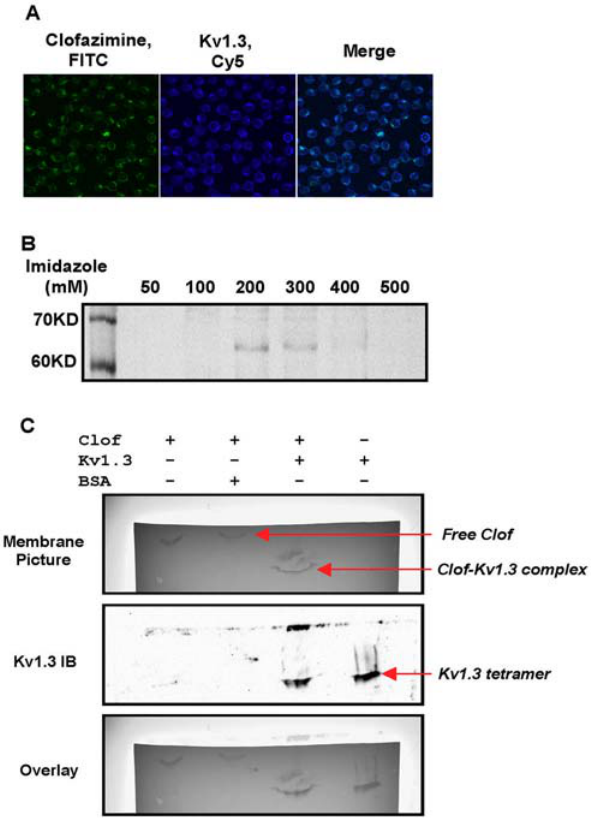
Figure 4. Interaction between clofazimine and Kv1.3 invivo and invtro. ( A ) Clofazimine colocalizes with Kv1.3 on the plasma membrane of Jurkat T cells. Clofazimine was visualized in FITC channel while Kv1.3 was stained by Cy5 secondary antibody. ( B ) SDS-PAGE analysis of His- Kv1.3 purified from 293 T cells upon staining with Coomassie blue. Recombinant Kv1.3 protein was found in the 200 and 300 mM imidazole elution fractions. ( C ) Gel shift of clofazimine by Kv1.3 on native polyacrylamide gel. 10 m M Clofazimine was incubated with buffer alone (lane 1), 2 m M BSA (lane 2) and 2 m M Kv1.3 (lane 3) for 30 minutes before the samples were resolved on a native polyacryl- amide gel. Proteins and clofazimine were transferred to nitrocellulose membrane. The presence of clofazimine was apparent by its intense organge/yellow color (member picture) and Kv1.3 was detected by Western blot analysis. The membrane image was taken in the same field after HRP detection was completed.